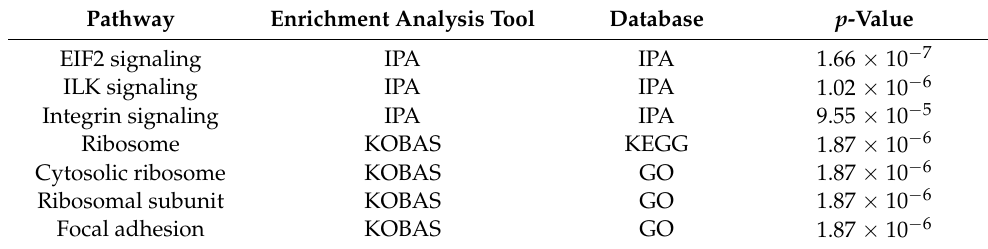
Figure 2. MA plot of the RNA sequencing output. The plot visualizes the differences in gene ex- pression in a log2 ratio (log2FC) between the two groups. Each dot represents a gene; red dots indicate differential expression (FDR < 0.01). indicate differential expression (FDR < 0.01). Table 3. Top three enriched pathways and GO terms, respectively, among genes with significantly higher expression in CETL samples resulting from enrichment analyses with KOBAS 3.0 and IPA.